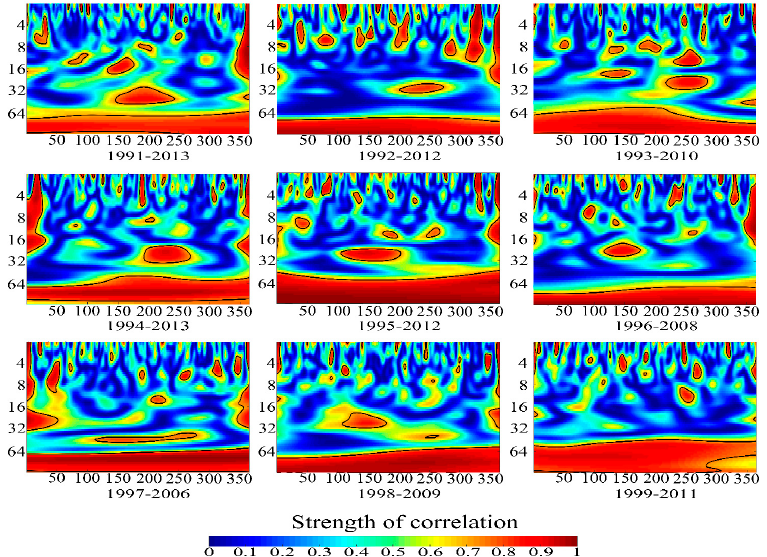
Figure 6. The correlations and similarities of precipitation patterns in the target years, from 1991 to 1999, and reference years from 2000 to 2013. The X-axis indicated the period along the whole year; the Y-axis indicated the temporal scales in day; the 95% confidence levels were shown as the thick solid lines; the color bar indicated strength of correlation. Table 2 displayed the quantitative evaluations of the correlations of precipitation patterns in the target years, from 1991 to 1999, and the reference years from 2000 to 2013, at different temporal scales. In accordance with the wavelet coherence results presented in Figure 6, the strongest correlations of precipitation patterns in the target years and the corresponding reference years were detected at long period (>64 day). Additionally, the values of MWC and PASC at long period temporal scale (>64 day) were larger than those at shorter temporal scales, in terms of MWC values (>0.79) and PASC values (>39.16%). Generally speaking, the mean values of MWC and PASC, at all scales, were larger than 0.42 and 19.58%, respectively. Table 2. Statistical results of wavelet coherence based on correlations and similarities of precipitation patterns in the target years, from 1991 to 1999, and reference years from 2000 to 2013. MWC